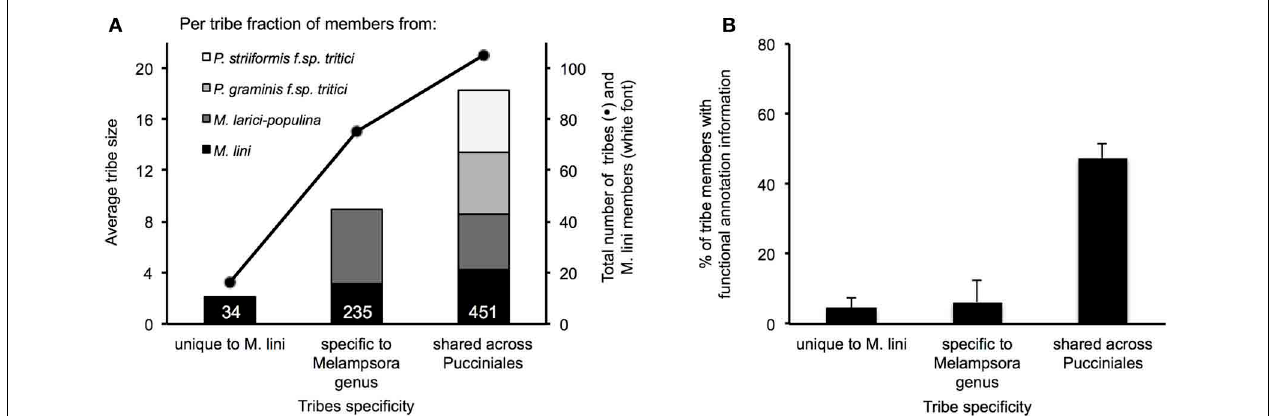
FIGURE 5 | Characteristics of the top 200 tribes of M. lini candidate effectors. Tribes were assembled with 2642 proteins coming from four rust species ( Mli , Mlp , Pgt , and Pst ), and all contain at least one member from Mli . Tribes were grouped according to whether they contain members from Mli only or members from the two Melampsora species only or members